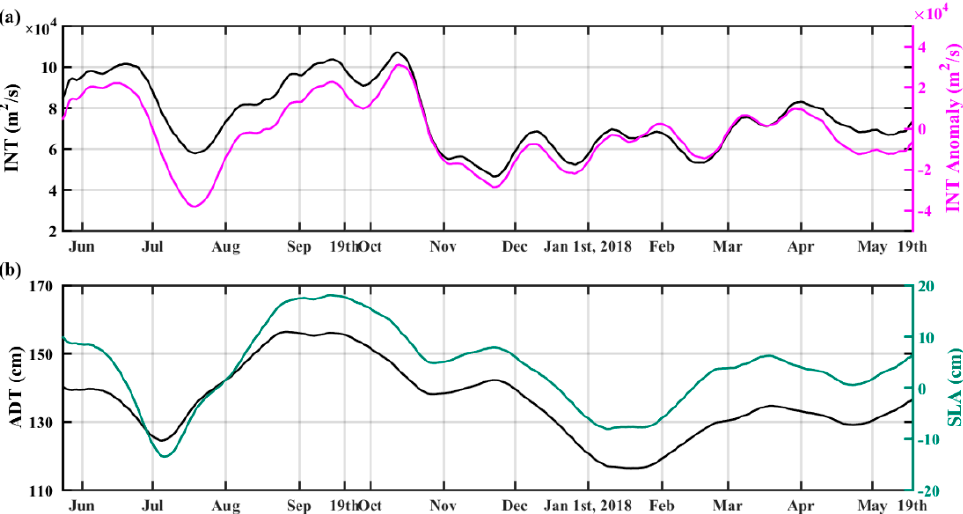
Figure 8. ( a ) The Kuroshio intensity (INT) and Kuroshio intensity anomaly through the K section derived from the altimeter data. The Kuroshio intensity anomaly was defined as a deviation from mean INT for the analysis period, and the seasonal variation was removed. ( b ) The ADT was the mean ADT derived from sea area of 22 ◦ N–24 ◦ N and 122 ◦ E–124 ◦ E east of Taiwan during the analysis period; the SLA was defined as a deviation from mean ADT for the analysis period, and the seasonal variation was removed. A 15-d low-pass filter was applied to the primary data.